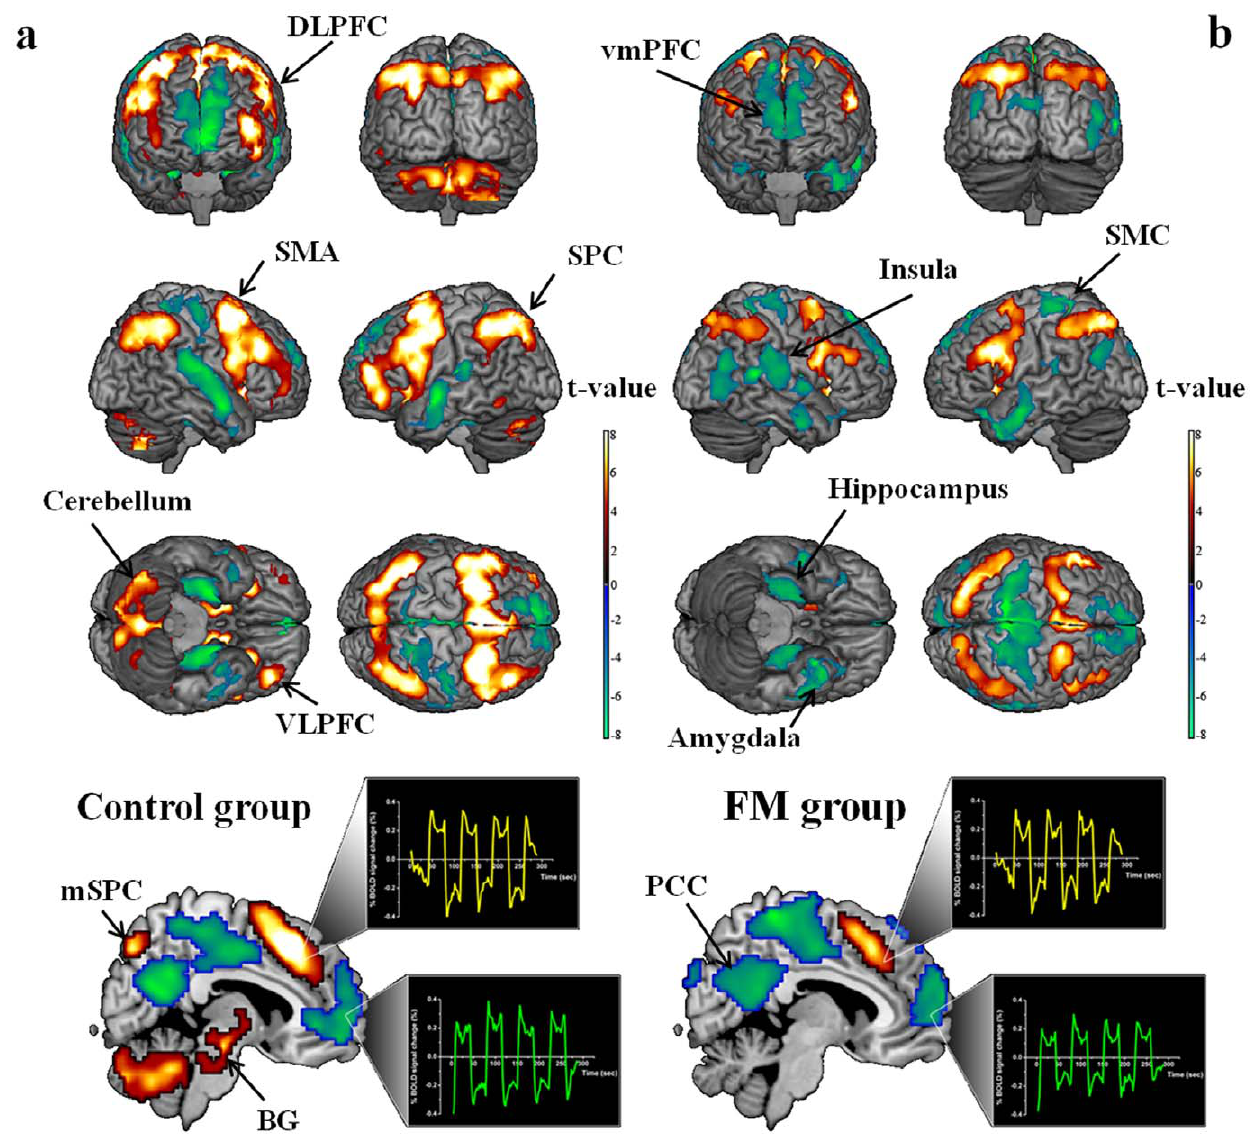
Figure 1. Within group analysis of n-back task. One-sample t-test group comparison in the control group (a) and in the fibromyalgia (FM) group (b). Both the task related activation regions (red to yellow) and the task related deactivation regions (blue to green) were represented in 3D brain template. The representative time course of blood oxygen level dependent (BOLD) signal at the dorsal medial prefrontal cortex (mPFC) demonstrated a positive signal change (yellow) during n-back task while the time course of BOLD signal at the anterior cingulate cortex (ACC) showed a negative signal change (green) during n-back task. The SPM{t}s were thresholded at P , 0.01, false discovery rate (FDR)-corrected for multiple comparisons across the whole brain for activation and deactivation. DLPFC: dorsolateral prefrontal cortex, SMA: supplemental motor area, SPC: superior parietal cortex, VLPFC: ventrolateral prefrontal cortex, BG: basal ganglia, vmPFC: ventral medial prefrontal cortex, PCC: posterior cingulate cortex.